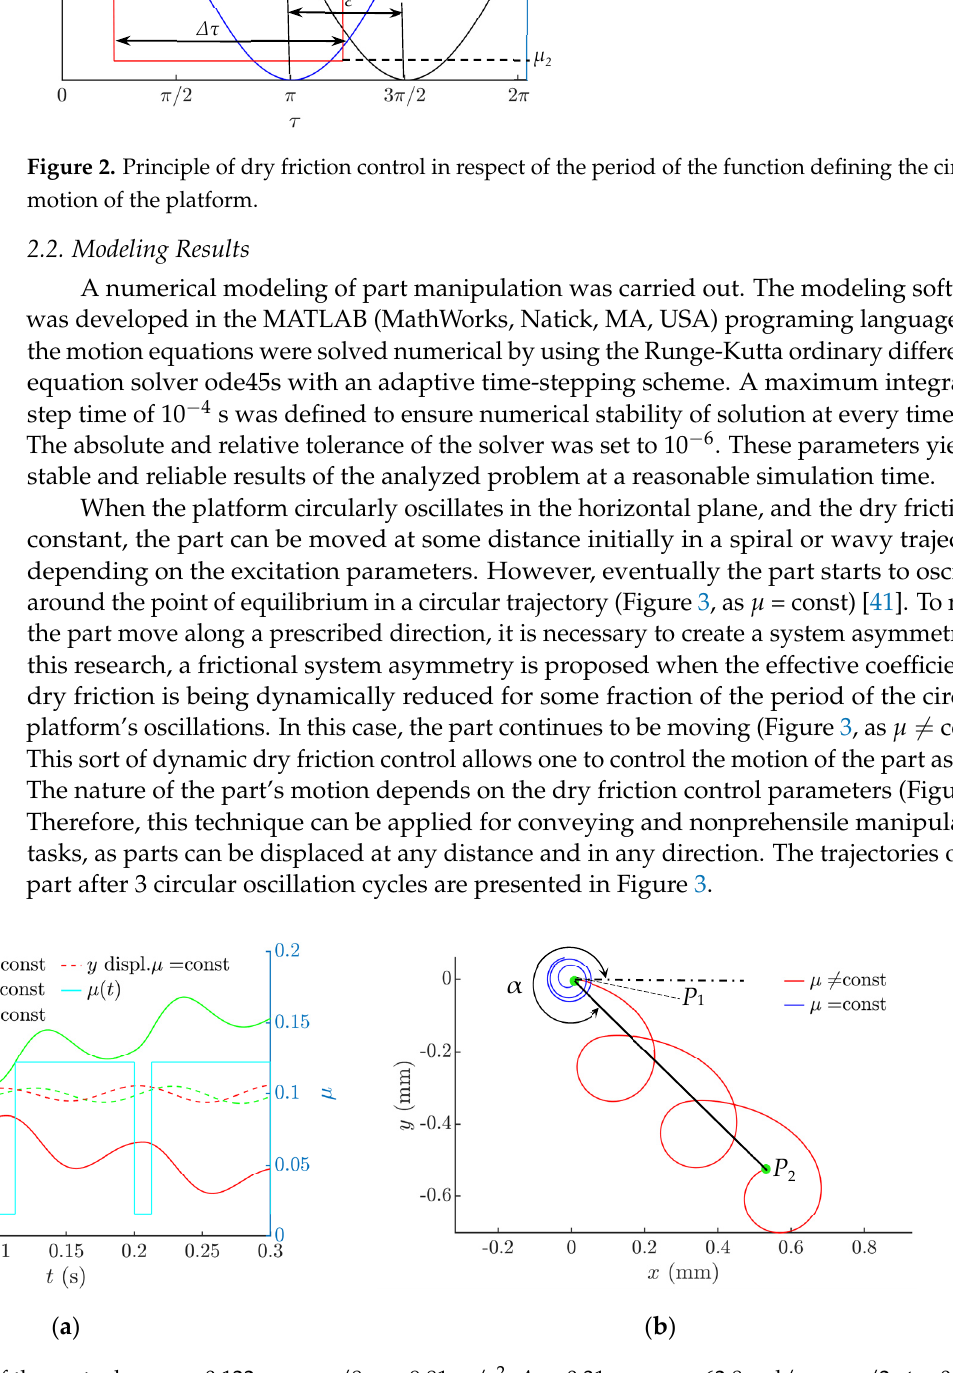
Figure 3. Displacement of the part when μ 1 = 0.122, μ 2 = μ 1 /8, g = 9.81 m/s 2 , A e = 0.31 mm, ω = 62.8 rad/s, ε = π /2, ϕ = 0, Δ τ = π /4: ( a ) displacement vs. time and the effective dry friction coefficient vs. time; ( b ) motion trajectory of the part and the angle of displacement α .